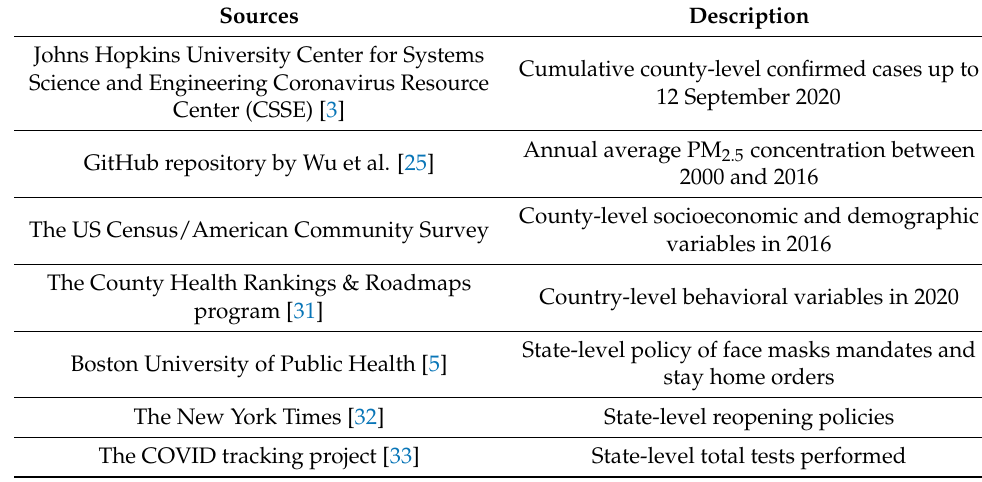
Table 2. Summary of data